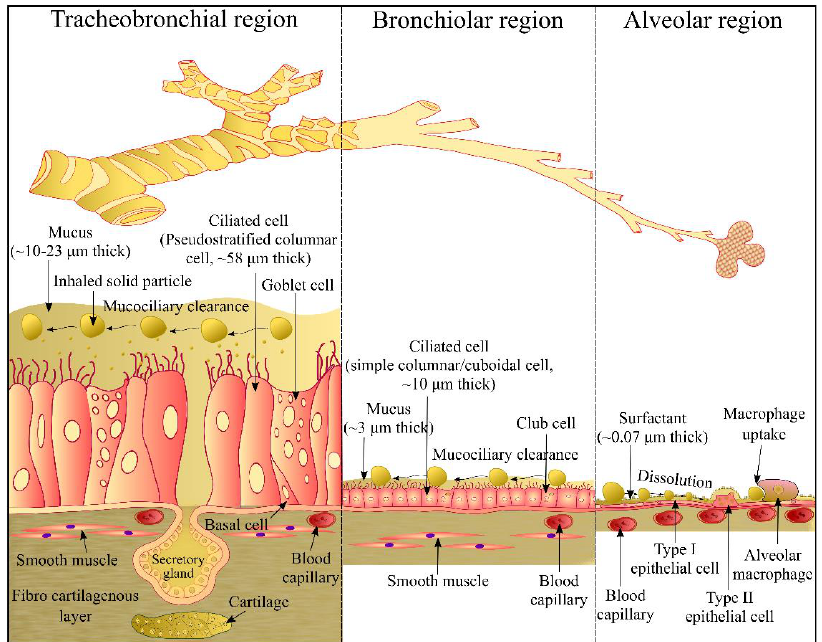
Figure 1. Comparison of the tracheobronchial, bronchiolar and alveolar regions of the lungs [32]. Reproduced with permission from Ref. [32]. 2015, McGraw Hill.